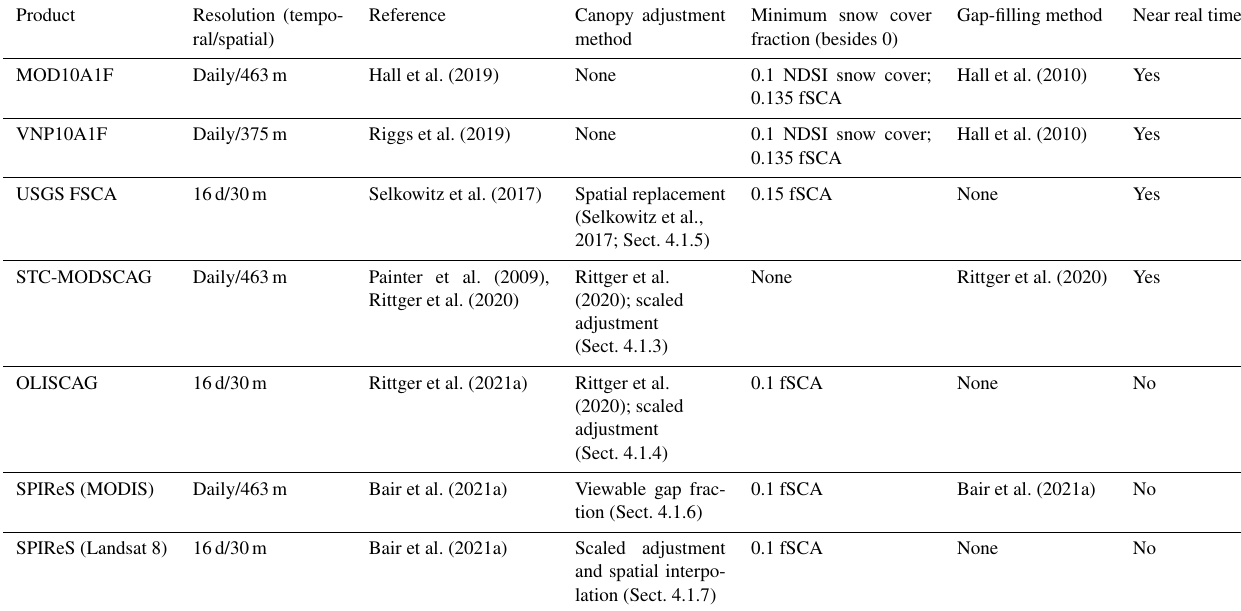
Table 2. Snow cover products validated in this study and their